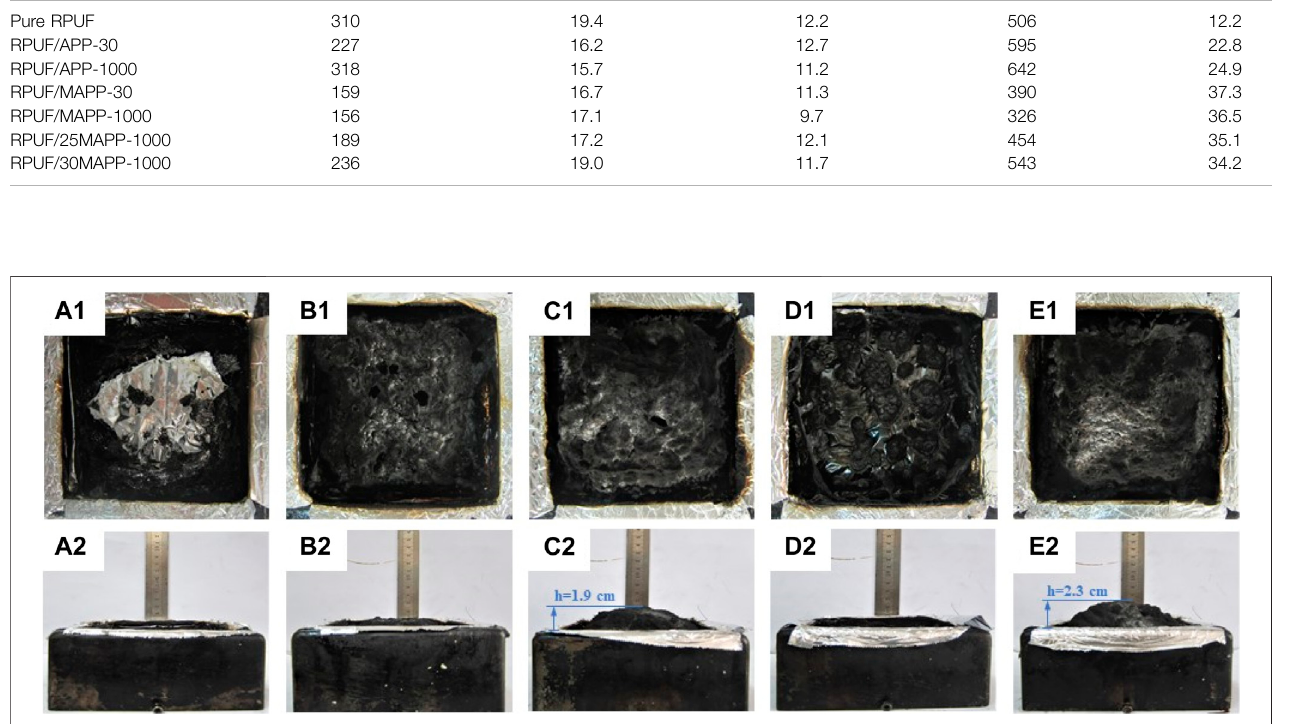
Frontiers in Materials |